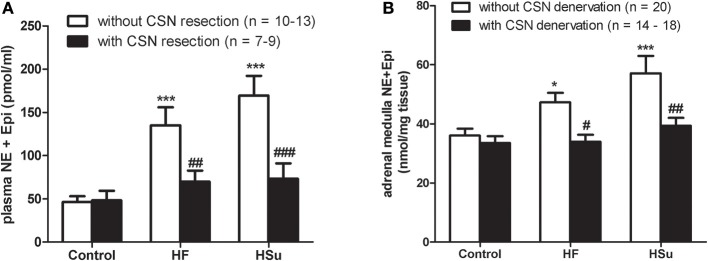
Effect of carotid sinus nerve resection on sympathetic nervous system activity, measured as circulating catecholamines [norepinephrine (NE) + epinephrine (Epi)] (A) and adrenal medulla catecholamines (NE + Epi) content (B), in control, high fat (HF) and high sucrose (HSu) diet rats. Bars represent mean ± s.e.m. Two-Way ANOVA with Bonferroni multicomparison tests; *p < 0.05, ***p < 0.001 vs. control; #p < 0.05, ##p < 0.01, ###p < 0.001 vs. values within the same group (adapted from Ribeiro et al., 2013).